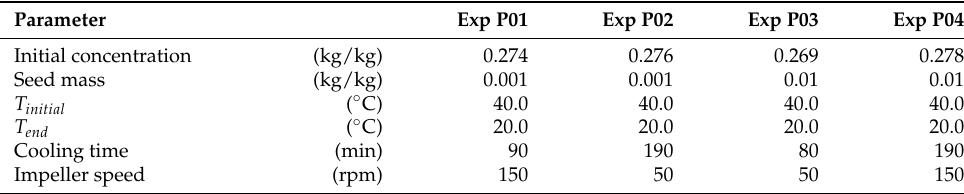
Table 2. Operating conditions of the